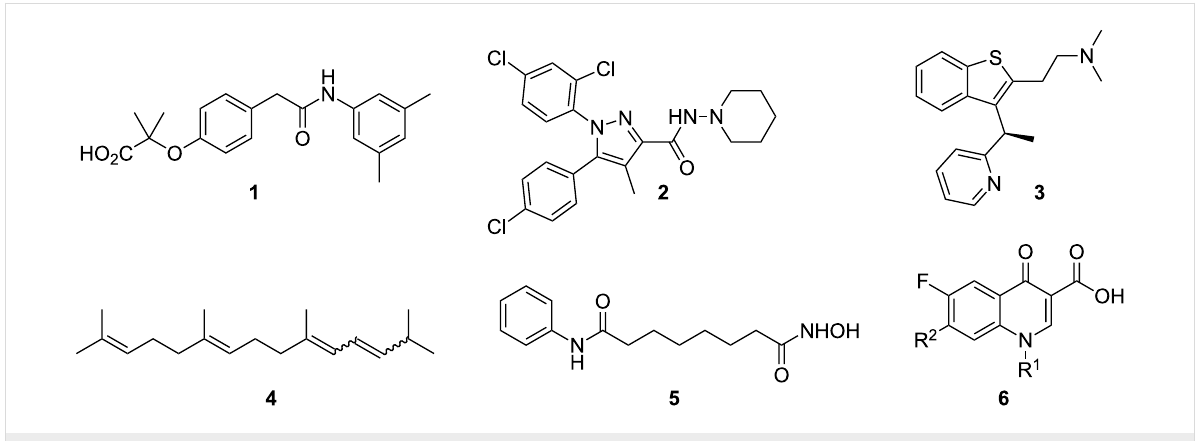
Figure 1: Pharmaceutical structures targeted in early flow syntheses.